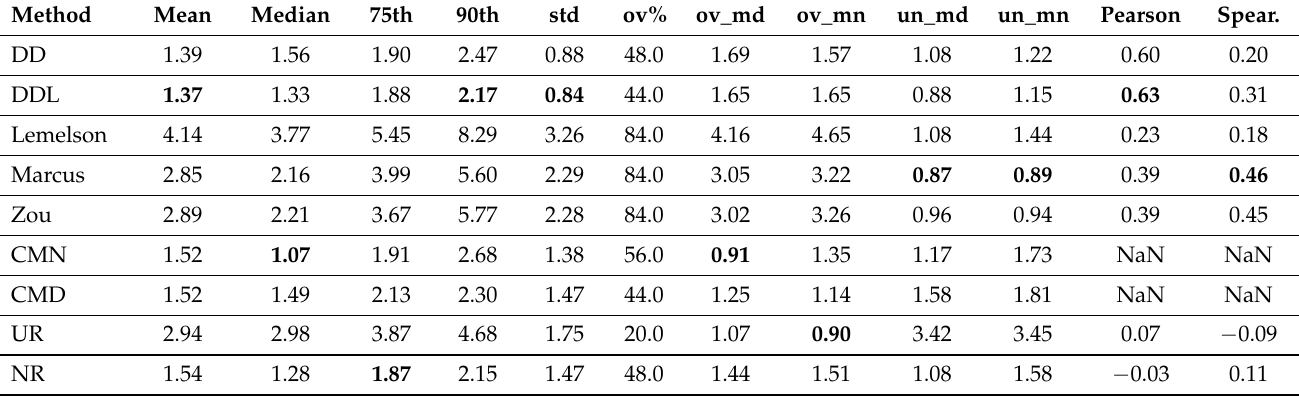
Figure 20. A radar plot of most of the relevant metrics for the DAE evaluation of various methods, on the validation set of the MAN dataset. Methods are depicted in continuous lines while baselines are in dashed lines. This plot depicts metrics and values of all methods, as reported in Table 7. Table 7. The performance of all studied methods and baselines, based on various evaluation metrics, on the validation set of the MAN dataset. The first 5 columns report statistics ( mean, median, 75th percentile, 90th percentile, and standard deviation ) of the absolute DAE error. The next column “ ov% ” describes the percentage of DAE overestimation (percentage of estimates where the actual location is “ inside the DAE circle ”). The mean and median DAE error of the overestimated estimates are reported under “ ov_ mn ” and “ ov_ md ”, respectively. The same statistics for the underestimation case are provided under “ un_ mn ” and “ un_ md ”, respectively. Lastly, Pearson’s correlation coefficient and Spearman’s (rank) correlation coefficient between the DAE values and the actual positioning errors are reported in the last two columns. The best performance for each metric is highlighted in